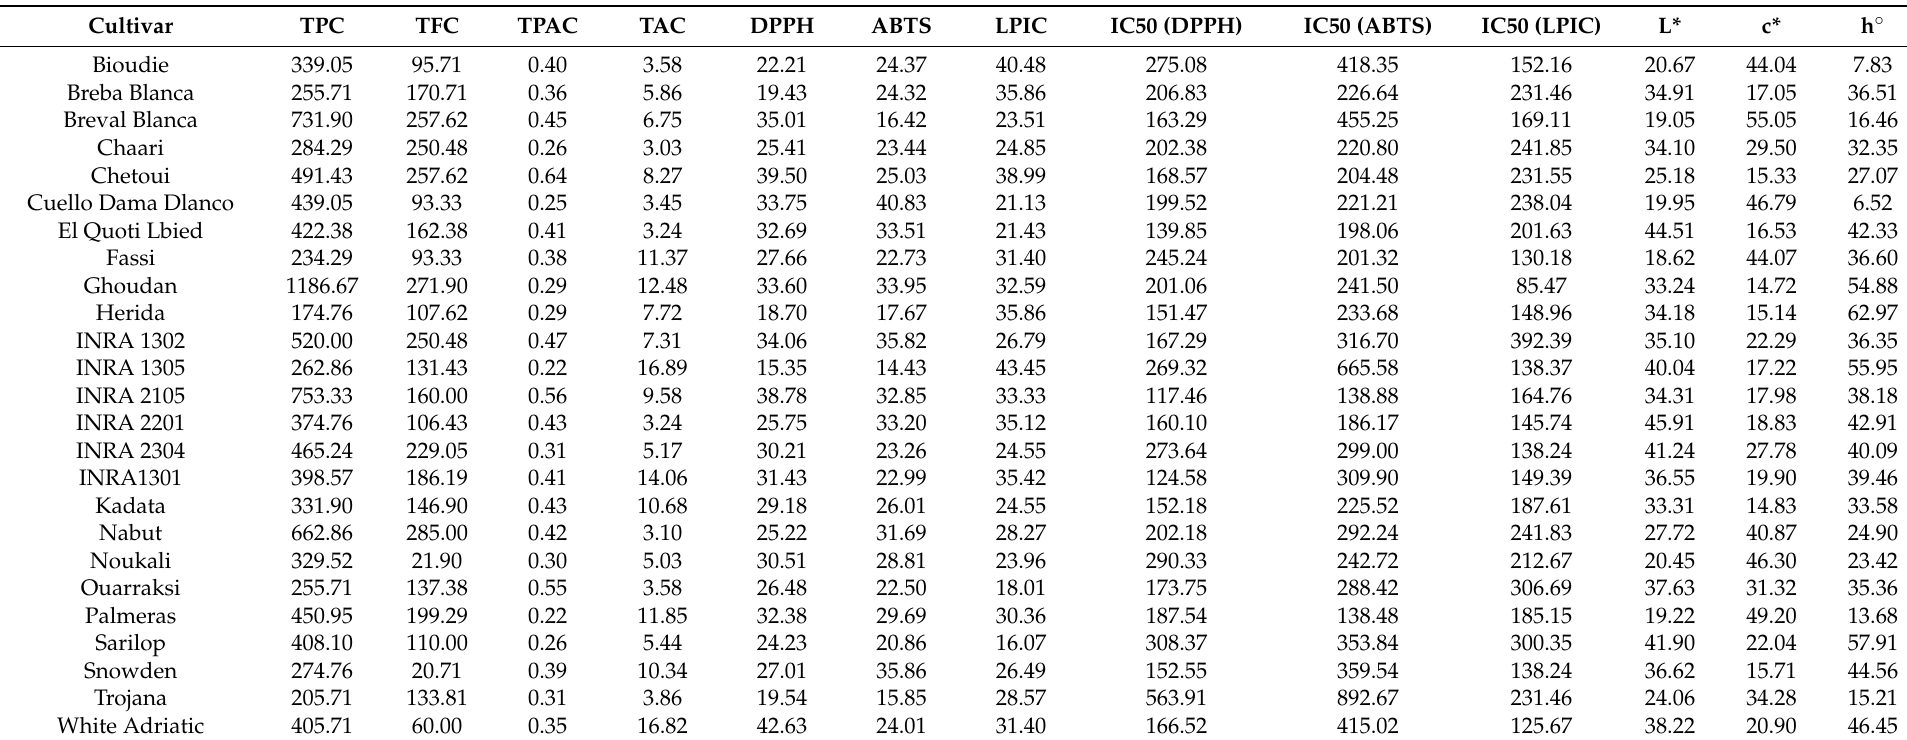
Table 3. Total phenols, flavonoids, anthocyanins, proanthocyanidins, antioxidant activity and chromatic coordinates of fig